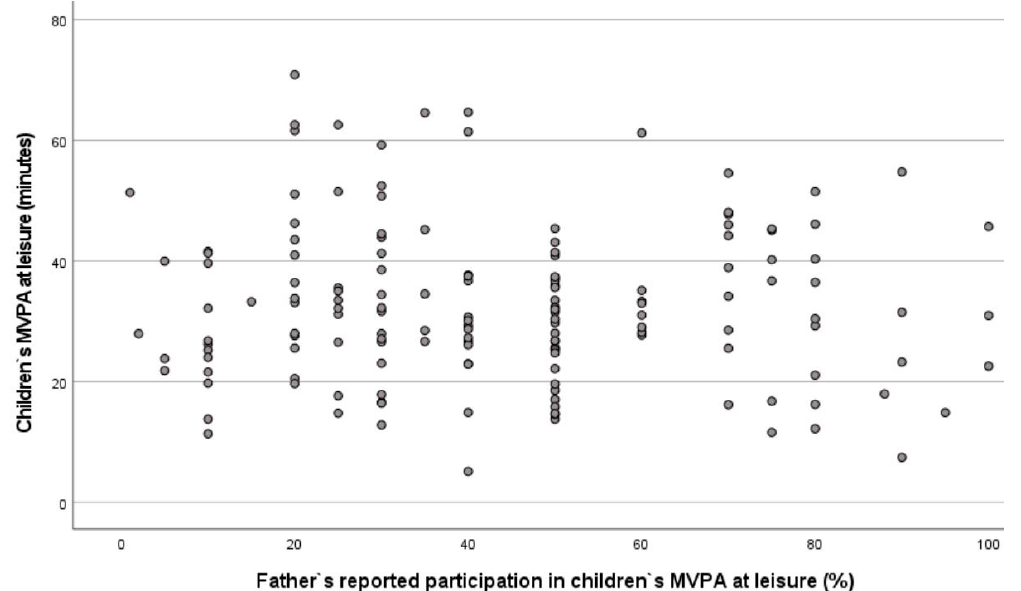
Figure 3. Scatter plot of preschool children’s MVPA at leisure time and mothers’ reported partici- pation in MVPA with their children.